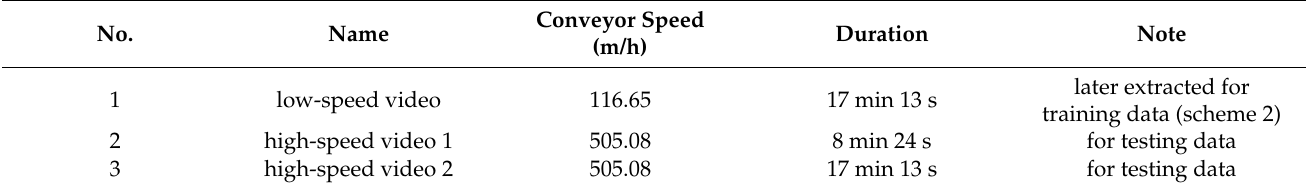
Table 2. Images dataset (videos).